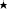
Principle coordinates analysis (PCoA) scores plot based on read counts of Symbiodinium subclades in coral samples from the tropical SY and subtropical XW and DY reefs in the northern SCS. The square (■) represents Acropora sp.; the star () represents G. fascicularis; the diamond (♦) represents P. lamellina; the circle () represents P. lutea; and the triangle () represents S. glaucum. For the same coral species or genus samples, different colors represent different reefs (red represents coral samples from tropical SY; green represents coral samples from subtropical XW; and blue represents coral samples from subtropical DY).